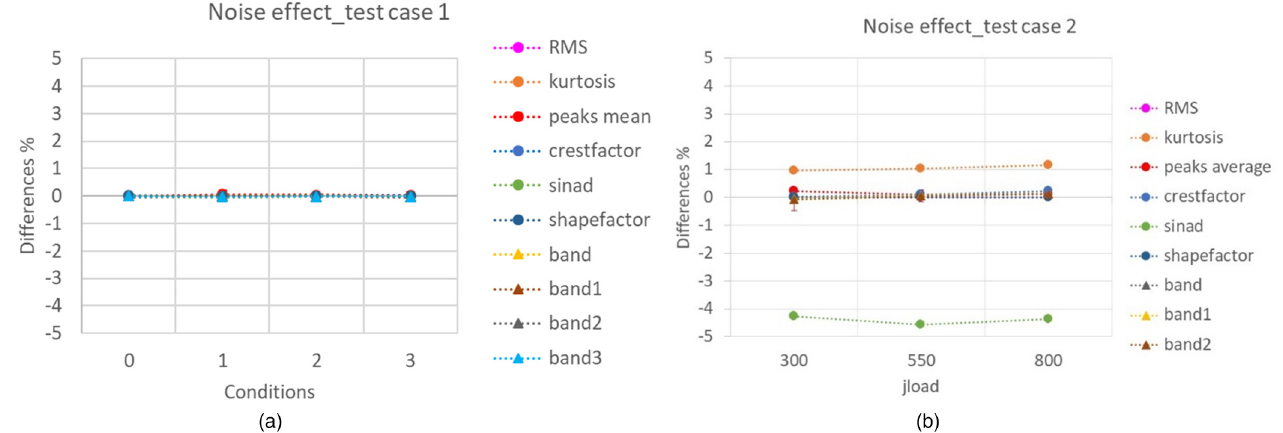
Fig. 5. Effect of the noise on features for CM, in cases 1 (a) and 2